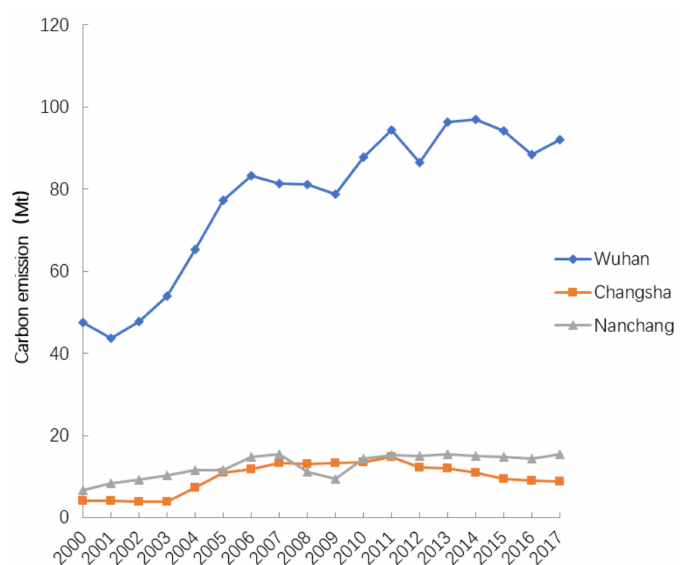
Figure 3. Total carbon emissions from Wuhan, Changsha, and Nanchang.